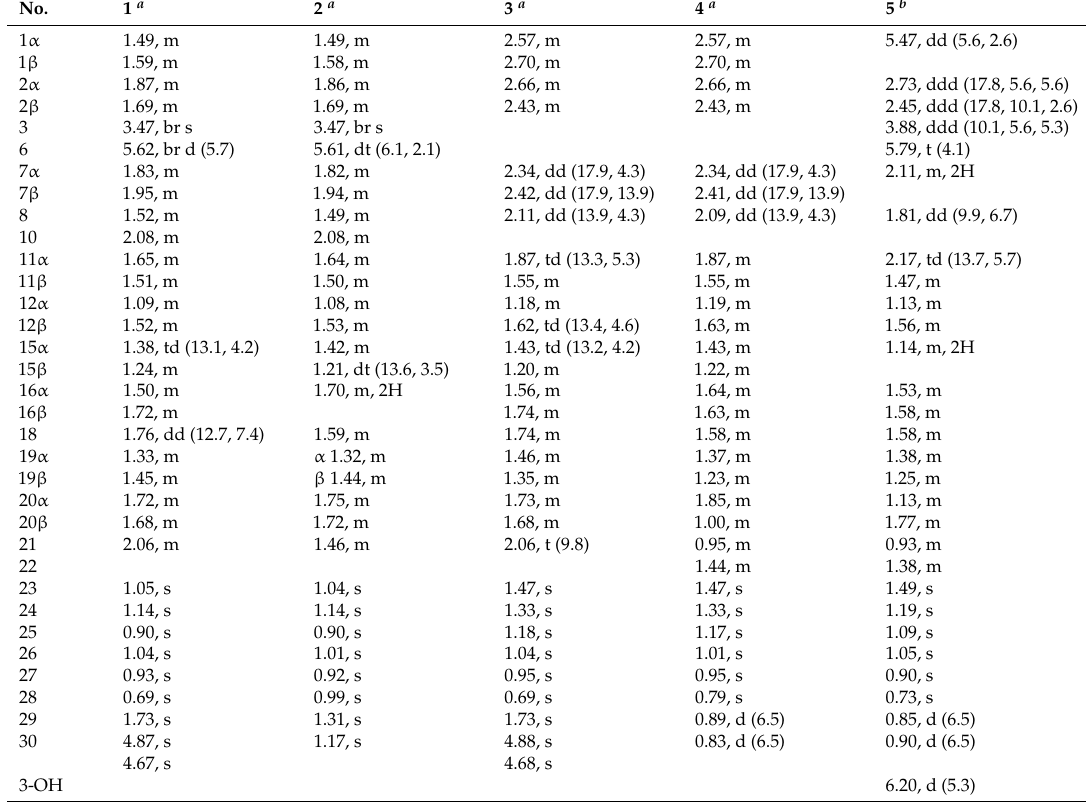
Table 1. 1 H NMR spectroscopic data for Compounds 1 – 5 .